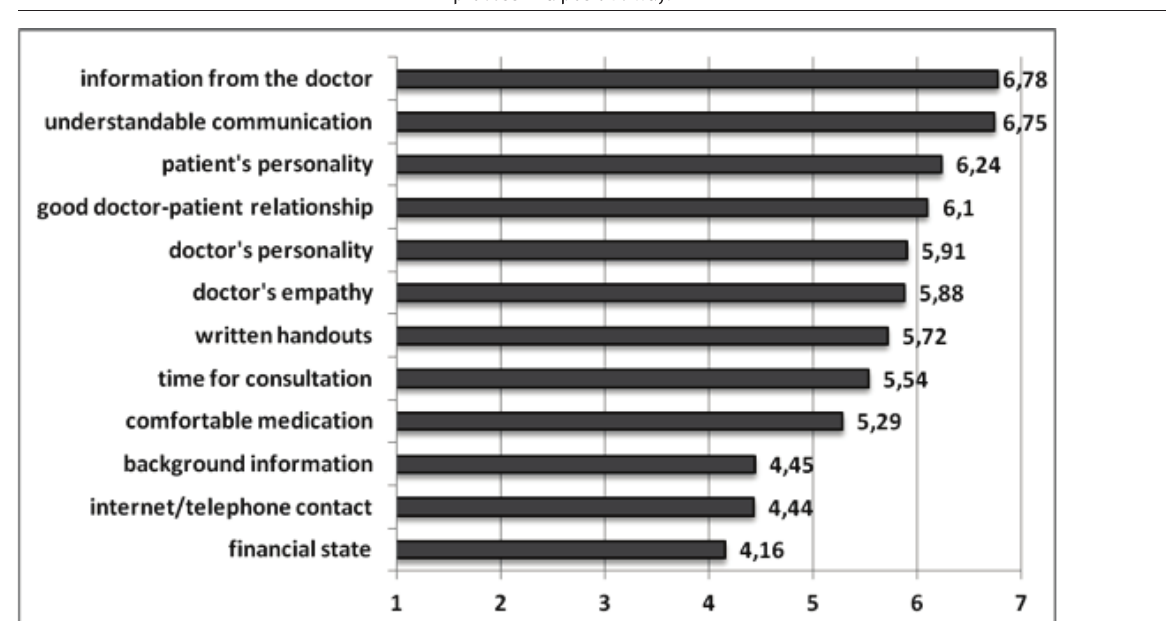
Figure 1. Patients’ rankings of the most important aspects of adherence. Questionnaire (7-point attitude scale) results with means of the scores